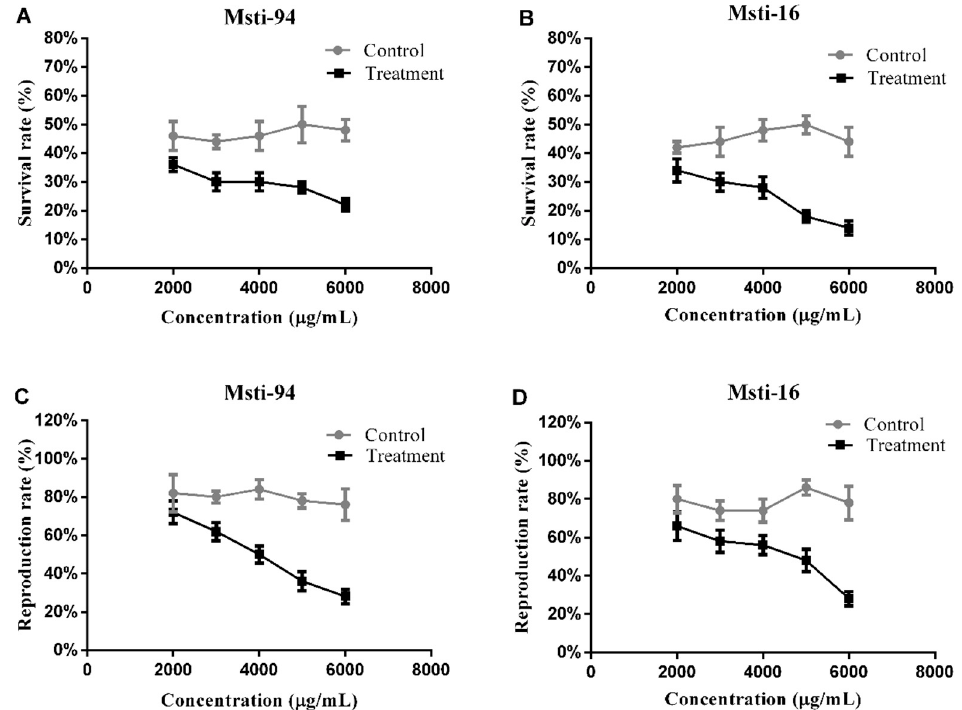
Figure 5. The survival rates of the aphids after 72 h at different concentrations of feeding with Msti- 94 ( A ); survival rates of the aphids after 72 h at different concentrations of feeding with Msti-16 ( B ); reproduction rates of the aphids after 72 h at different concentrations of feeding with Msti-94 ( C ); the reproduction rates of the aphids after 72 h at different concentrations of feeding with Msti-16 ( D ). Control refers to the artificial feed without any inhibitors (non-induced bacterial sample), and treatment refers to the artificial feed with inhibitors.